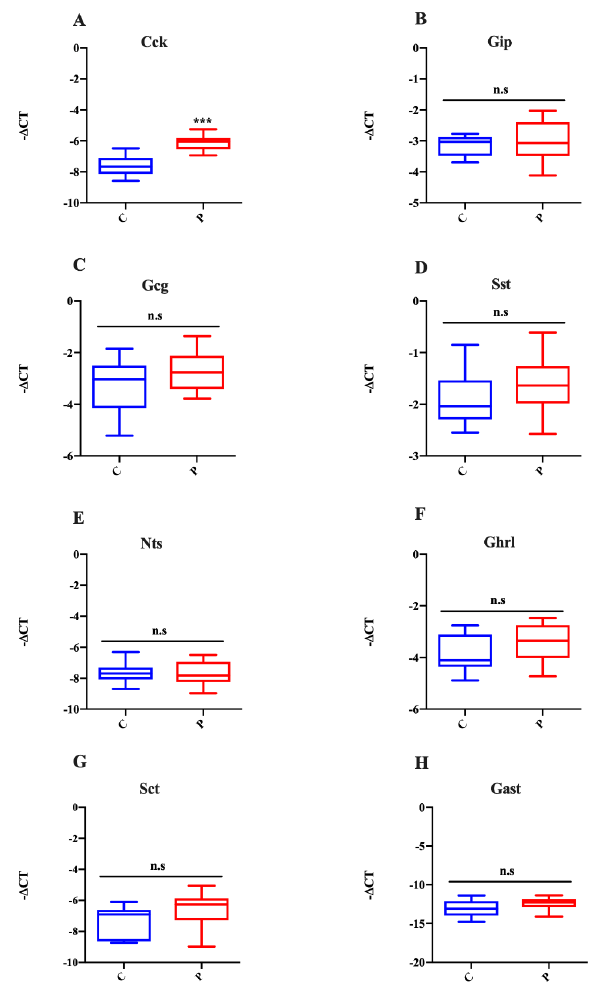
Figure 5. Action of palmitate exposure on EEC markers. Expression of CCK ( A ), Gip ( B ), Glp ‐ 1 ( C ), Sst ( D ), Nts ( E ), Ghrl ( F ), Sct ( G ) and Gast ( H ) in intestinal organoids treated with palmitate for 48 h. Data generated from three biological replicates from five mice. Unpaired Student’s t test: *** p < 0.001; n.s., not significant. C, control; P, palmitate.